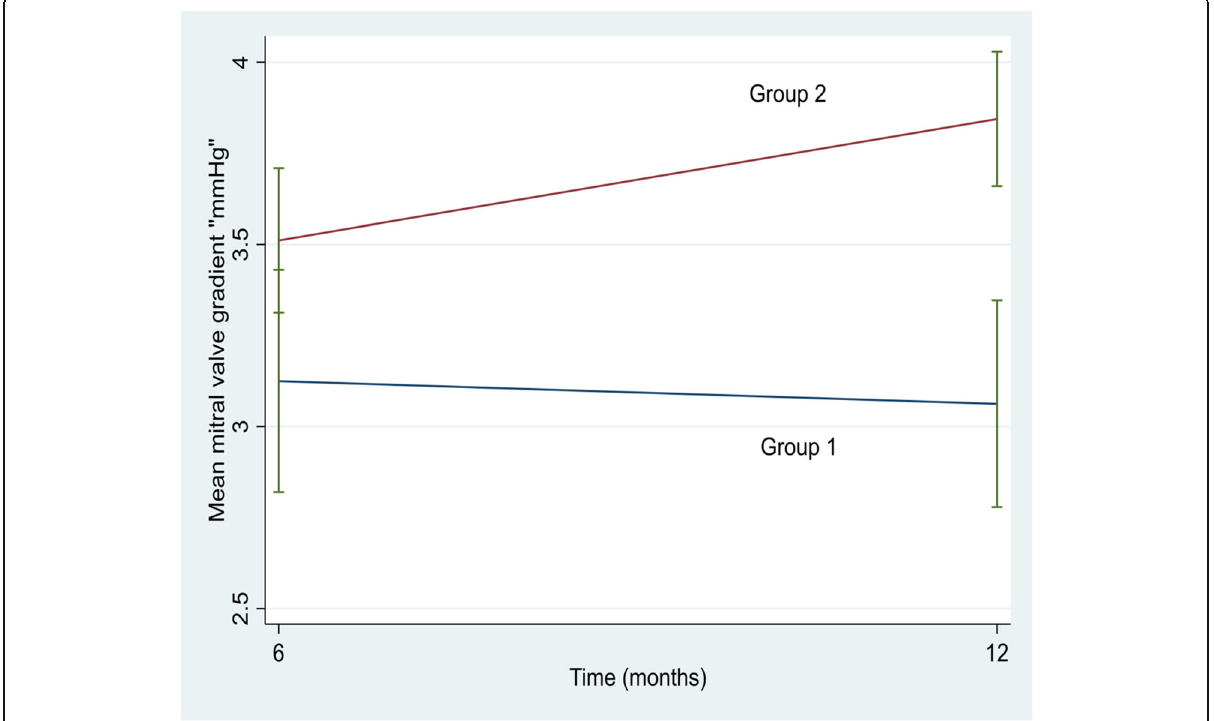
Fig. 1 Change in the mean mitral valve gradient between